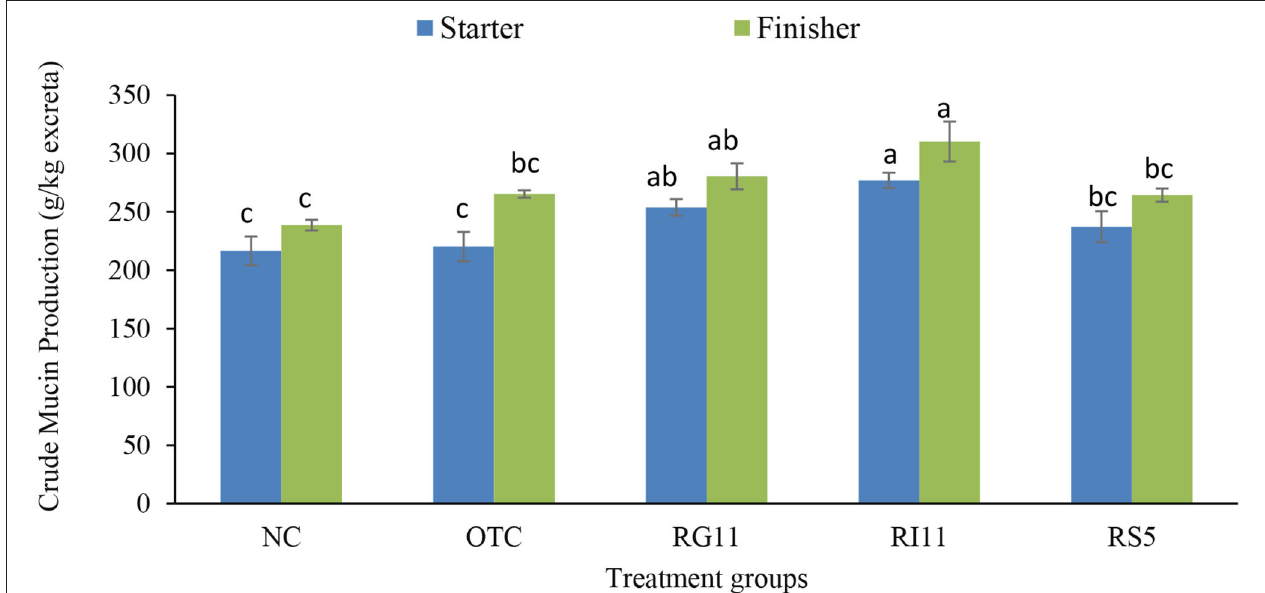
FIGURE 1 | Quantification of crude mucin in broiler excreta when supplemented with different postbiotics. abc Bar with different superscripts differ significantly at p < 0.05. Treatment groups: NC: basal diet only (negative control), OTC: basal diet + 0.01% oxytetracycline (positive control), RG11: basal diet + 0.1% Postbiotic RG11,